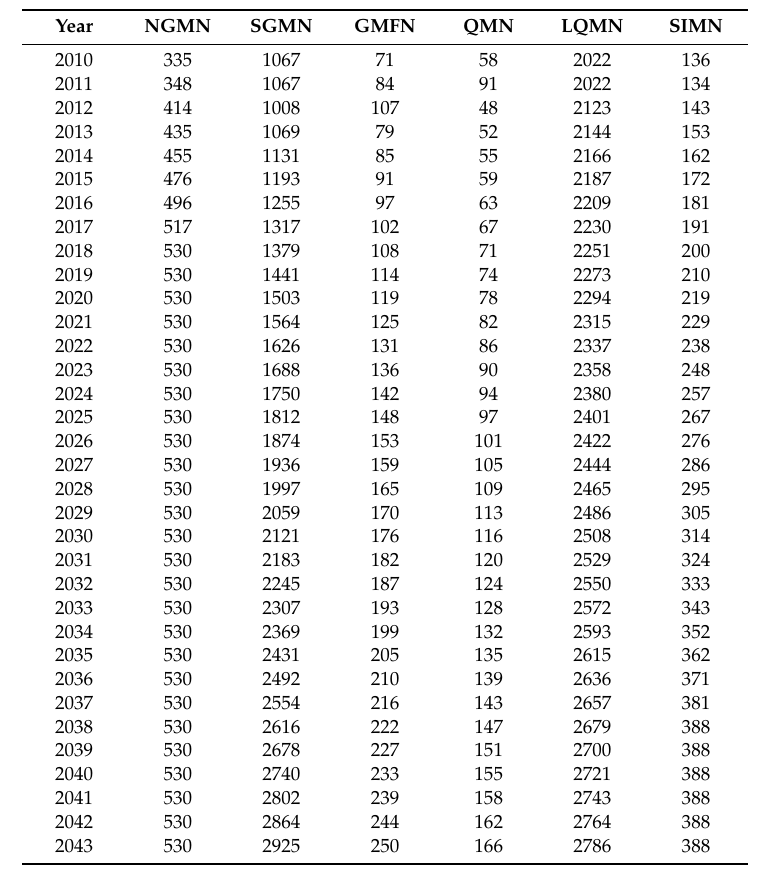
Table A7. Projection of groundwater monitoring wells by